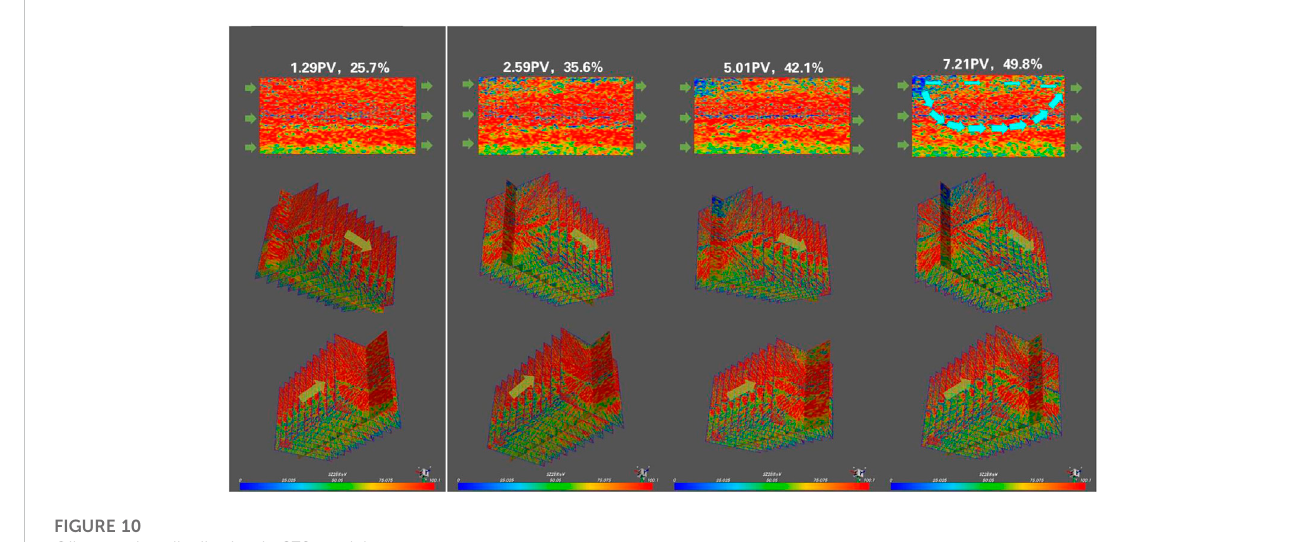
FIGURE 10 Oil saturation distribution in SZ2 model.